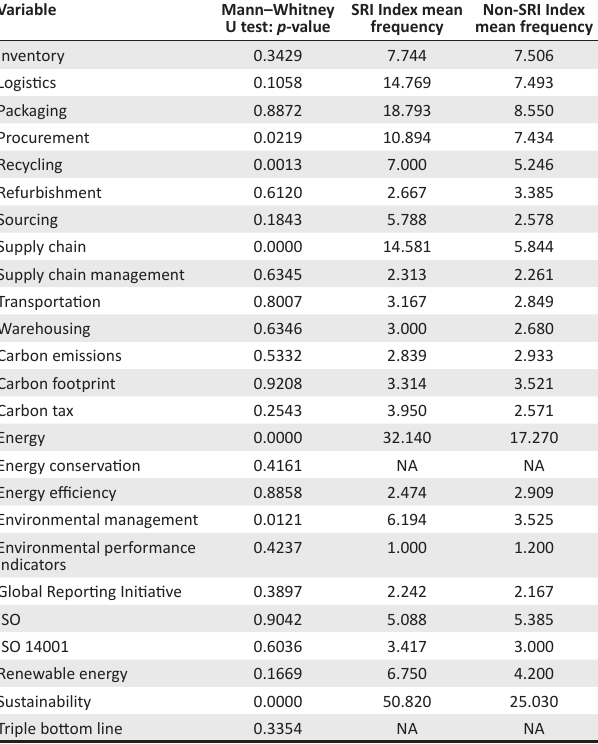
TABLE 7: Socially Responsible Investment Index comparison: Mann–Whitney U test results. Variable